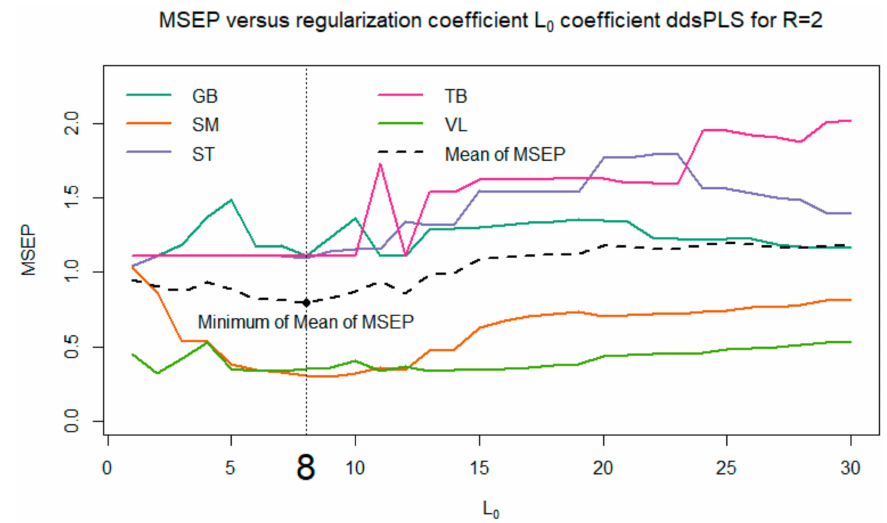
Figure 6. Evolution of the mean square error in prediction for each tenderness muscle and for the